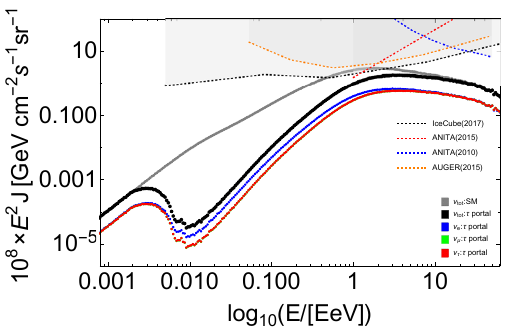
E 2 for the total neutrinos (black), ν e (blue), × = 0 . 4. The constraints = 15 MeV and U τ ˜ y τ τ | |